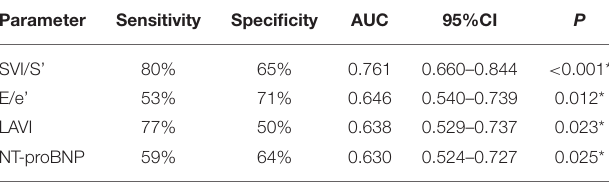
TABLE 5 | Receiver-operating characteristic curves for the diagnosis of HFpEF. Parameter